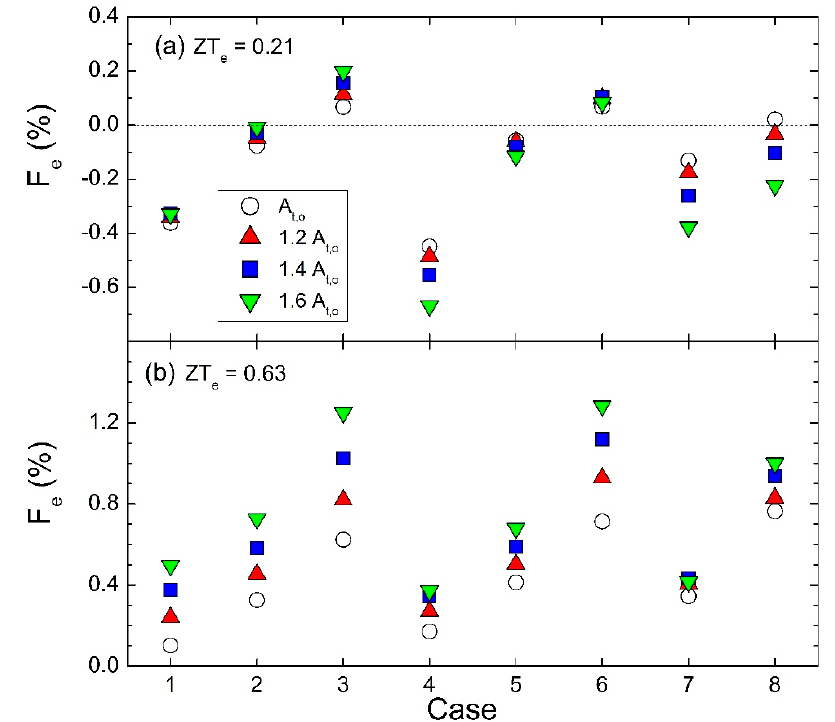
Figure 14. Fuel economy for those cases analyzed in Figure 11 using TEMs with an effective figure of merit ( a ) ZT e = 0.21 and ( b ) ZT e = 0.63. Numerical results.